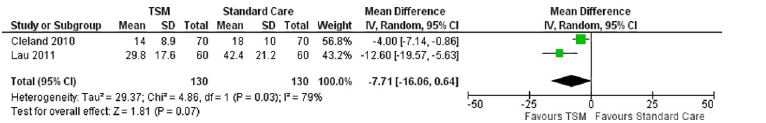
Fig 5. Meta-analysis of TSM versus standard care for pain at long-term